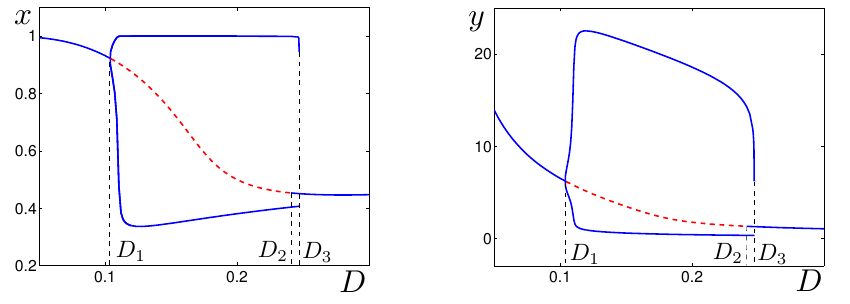
Figure 1. Bifurcation diagram for γ = 0.03, S = 0.7.